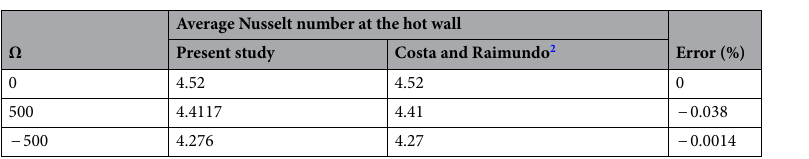
Average Nusselt number at the hot wall